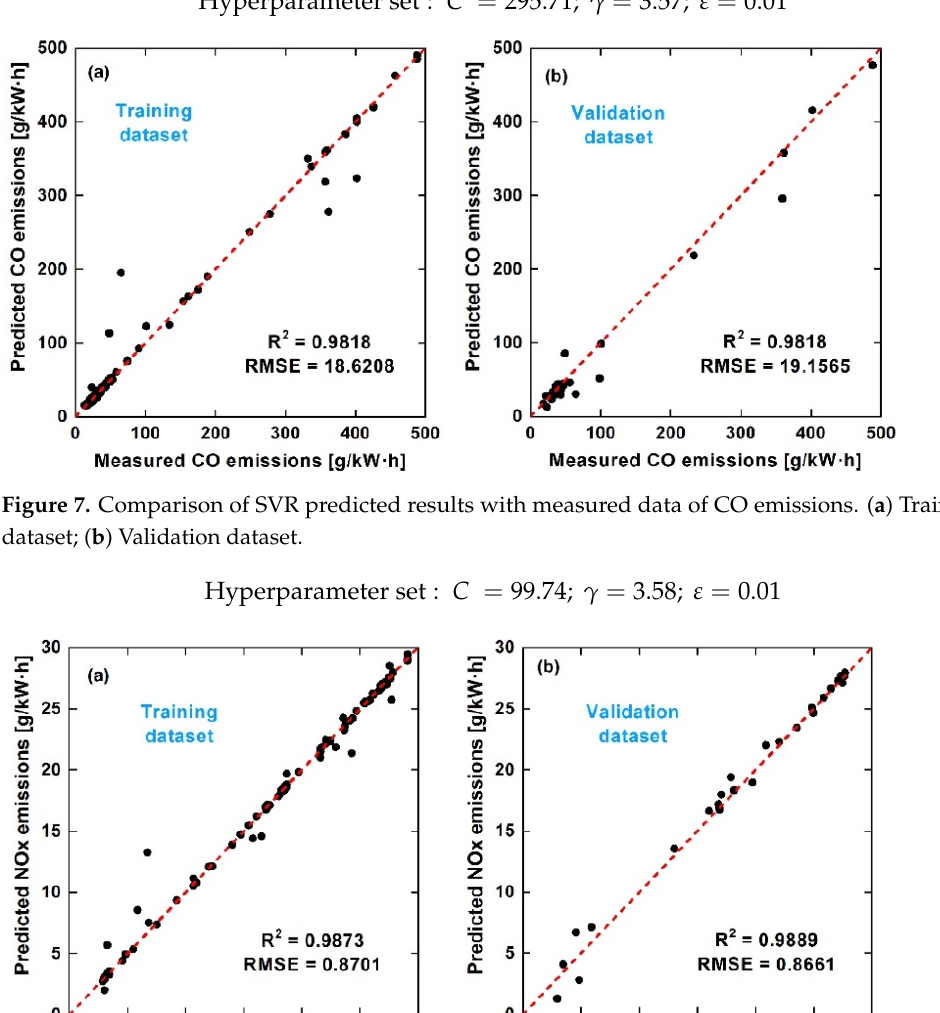
Figure 6. Comparison of SVR predicted results with measured data of HC emissions. ( a ) Training dataset; ( b ) Validation dataset.